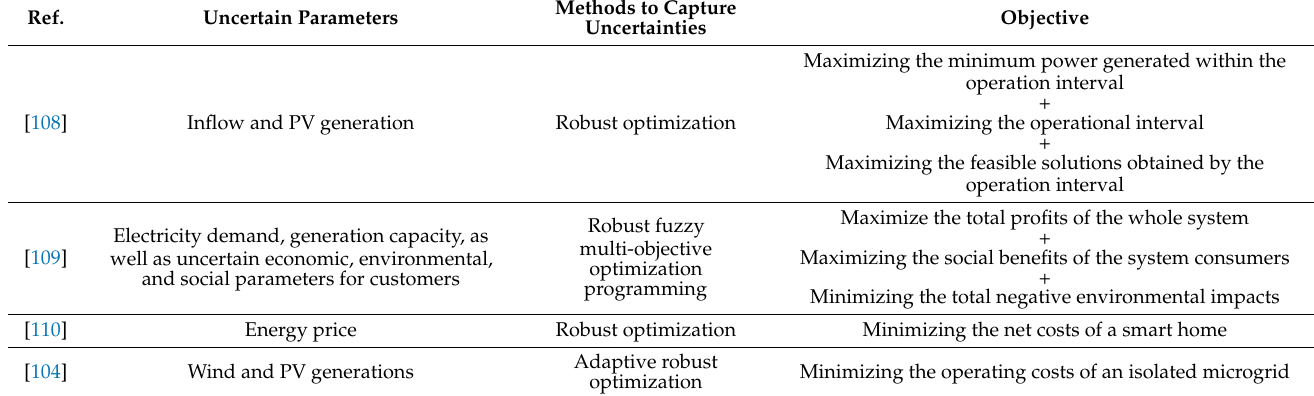
Table 7. An overview of recent papers using robust programming for decision making in a smart grid